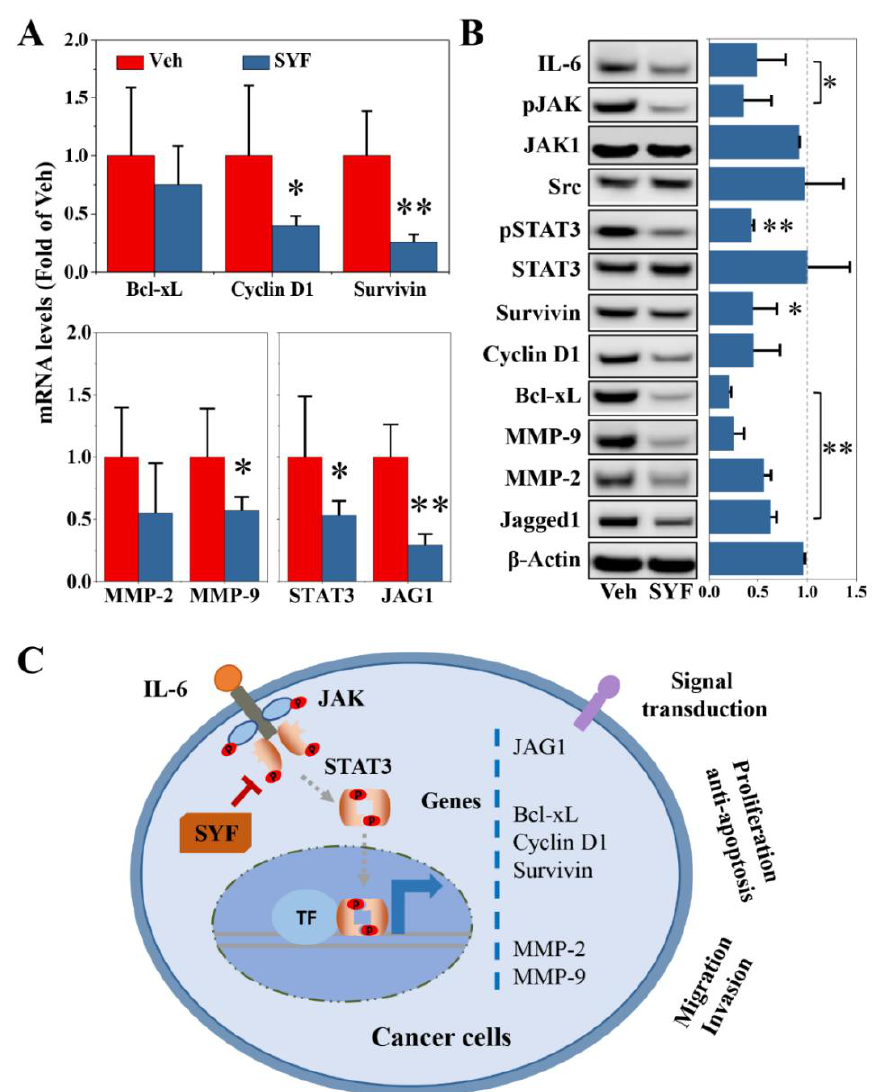
Figure 9. SYF reduced breast cancer cell metastasis by regulating cell cycle-, migration-, and invasion-related genes. ( A ) Effects of SYF on mRNA expression. Breast cancer cells were incubated with or without SYF (100 µ g/mL) for 24 h and harvested for total RNA extraction. qPCR was used to determine mRNA expression (N = 3). ( B ) Representative pictures of the effect of SYF on candidate target proteins and relative quantitative results (fold of Veh). Breast cancer cells were incubated with or without SYF (100 µ g/mL) for 24 h and harvested for total protein extraction. Western blotting was used to determine protein expression (N = 3). ( C ) Schematic diagram of the inhibitory mechanism of SYF in breast cancer. JAG1, Jagged1. * p < 0.05, ** p < 0.01 vs. Veh